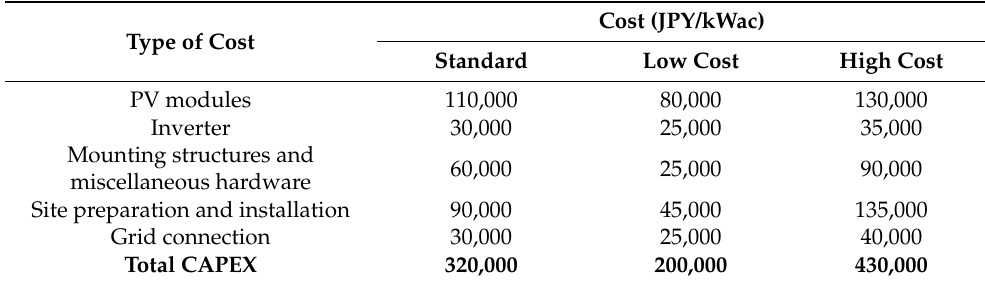
Table 5. CAPEX of each cost factor in JPY/kWac for